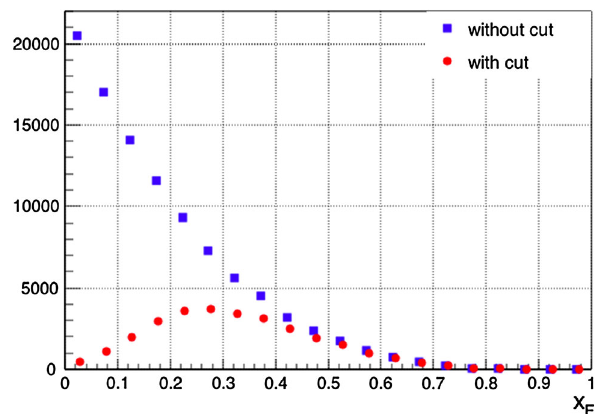
Fig. 1 The squared ( blue ) points represent the pQCD motivated x F distribution of (cid:4) ++ cc baryons. The circular ( red ) points show this dis- tribution with the experimental geometry cut (cf. Ref. [2])